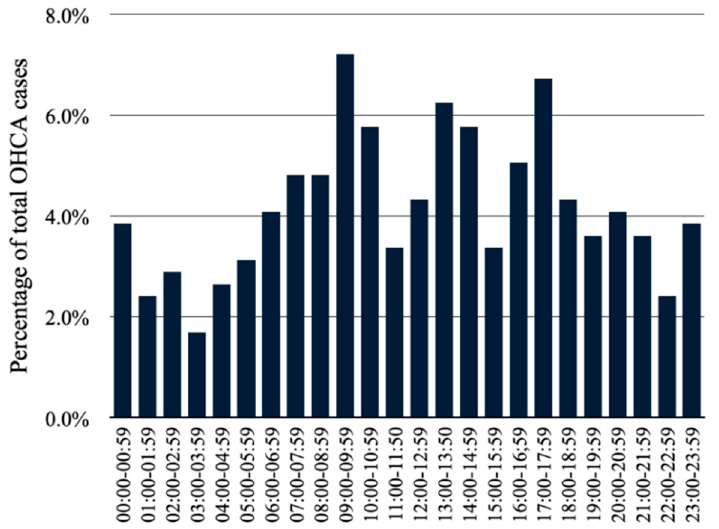
Figure 1. Circadian distribution of out-of-hospital cardiac arrest (OHCA) occurrence divided into 1 h intervals in 2020 ( p < 0.001).